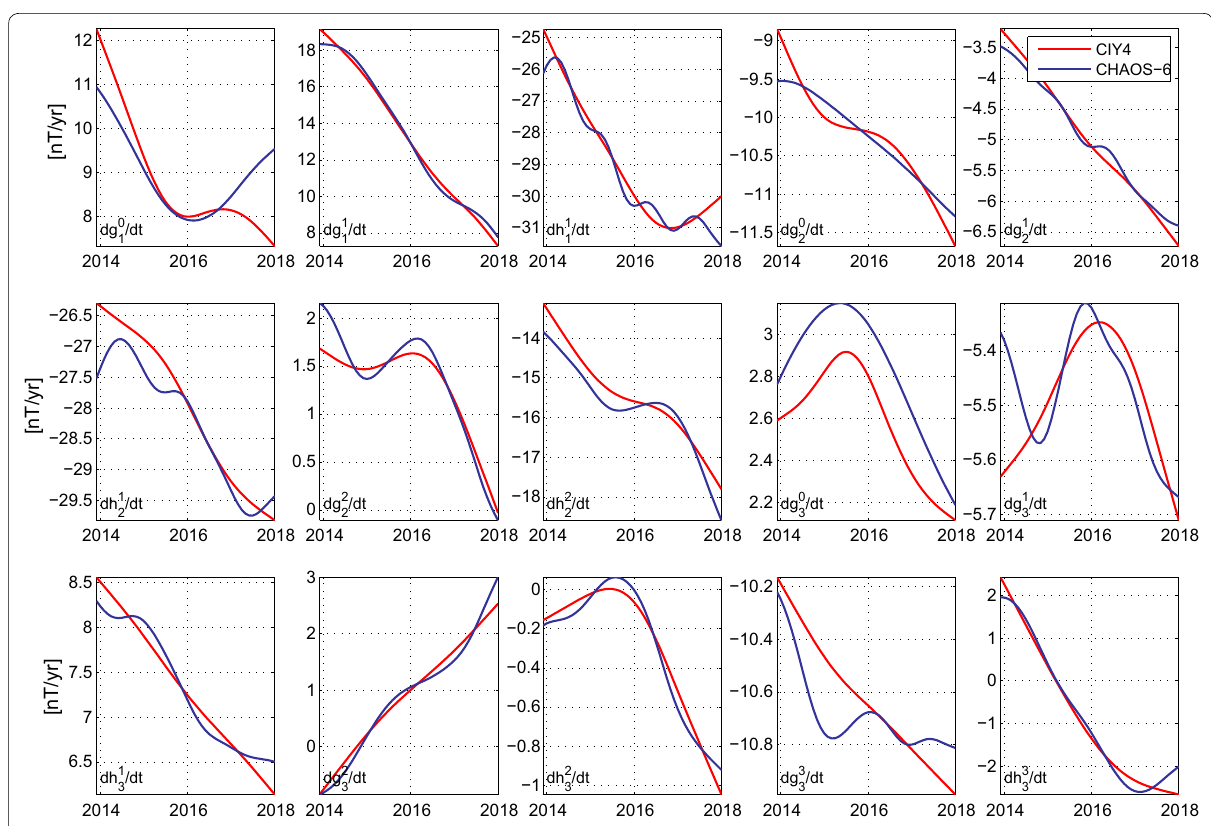
Fig. 4 The CIY4 (red) and CHAOS‑6‑x5 (blue) SV coefficients from 2014 to 2018 for SH degrees n = 1 −